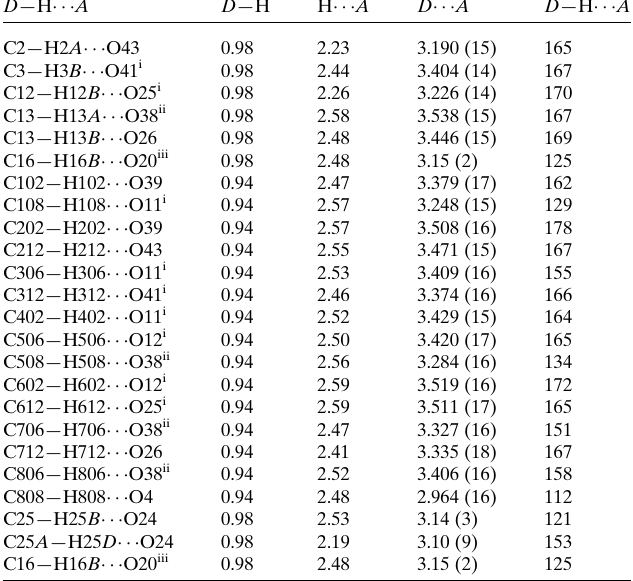
Table 3 Hydrogen-bond geometry (A˚ , (cid:3) ) for 4